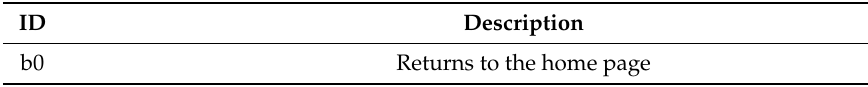
Figure 6. Glove failure page with paused elapsed time and touch number. Table 9. Description of the button found on the glove failure page. Table 8. Description of each text field found on the glove failure page.